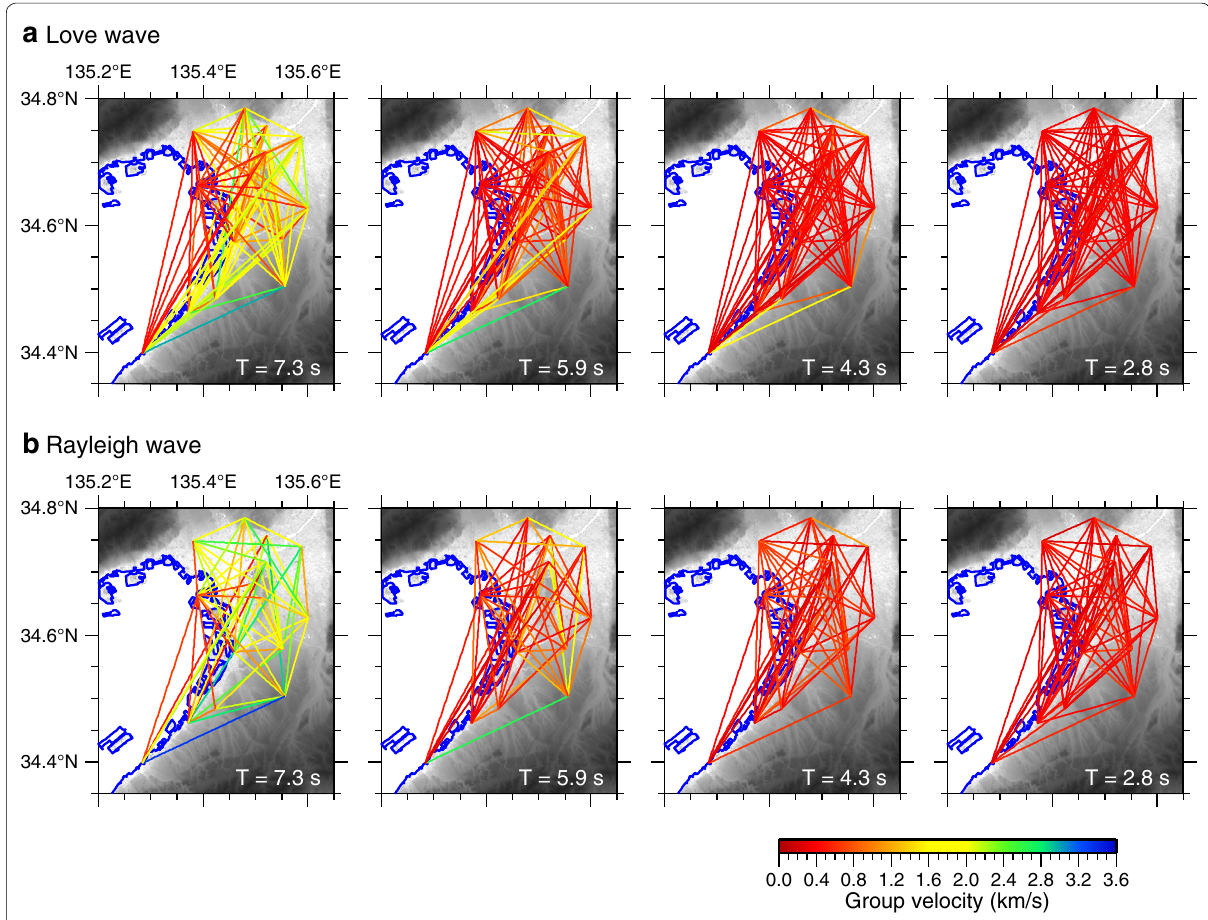
Fig. 9 Love and Rayleigh wave group velocities along the ray path of each station pair at periods of 7.3, 5.9, 4.3, and 2.8